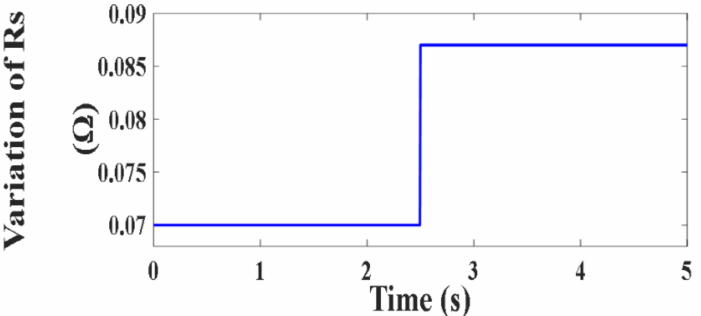
Figure 72. Variation of R s ( Ω ).